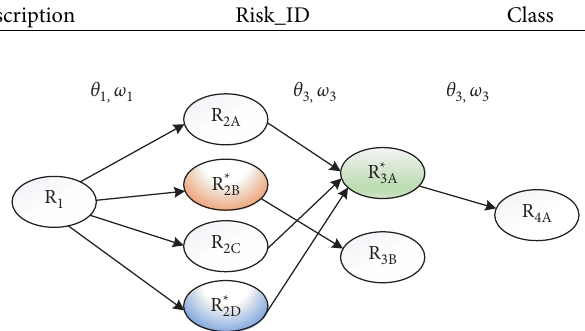
Figure 1: Key hazard and risk chain